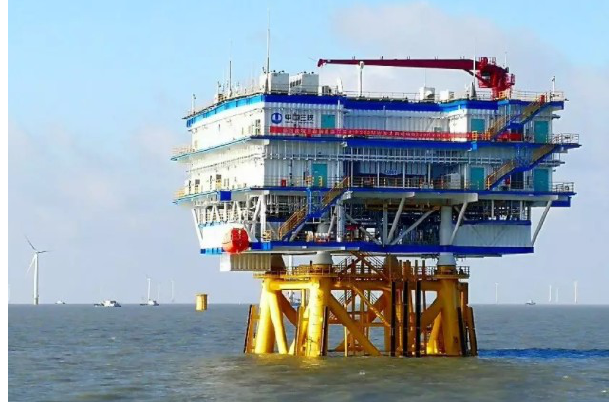
Figure 15. Offshore booster